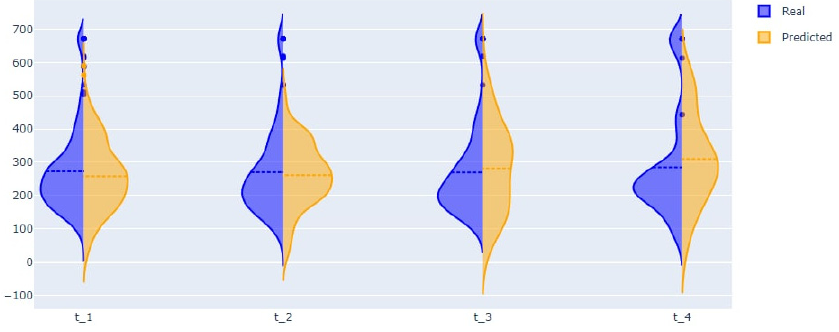
Figure 11. Real and predicted distribution of